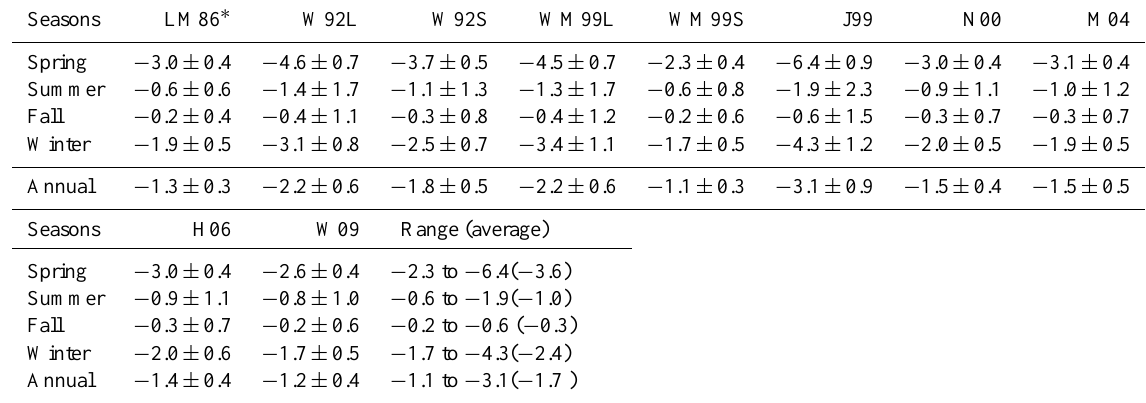
Table 4. Seasonal average CO 2 fluxes between 1998 and 2010 derived from the reported gas-transfer algorithms ∗ . Seasons LM86 ∗ W92L W92S WM99L WM99S J99 N00 M04 Spring − 3.0 ± 0.4 − 4.6 ± 0.7 − 3.7 ± 0.5 − 4.5 ± 0.7 − 2.3 ± 0.4 − 6.4 ± 0.9 − 3.0 ± 0.4 − 3.1 ± 0.4 Summer − 0.6 ± 0.6 − 1.4 ± 1.7 − 1.1 ± 1.3 − 1.3 ± 1.7 − 0.6 ± 0.8 − 1.9 ± 2.3 − 0.9 ± 1.1 − 1.0 ± 1.2 Fall − 0.2 ± 0.4 − 0.4 ± 1.1 − 0.3 ± 0.8 − 0.4 ± 1.2 − 0.2 ± 0.6 − 0.6 ± 1.5 − 0.3 ± 0.7 − 0.3 ± 0.7 Winter − 1.9 ± 0.5 − 3.1 ± 0.8 − 2.5 ± 0.7 − 3.4 ± 1.1 − 1.7 ± 0.5 − 4.3 ± 1.2 − 2.0 ± 0.5 − 1.9 ± 0.5 Annual − 1.3 ± 0.3 − 2.2 ± 0.6 − 1.8 ± 0.5 − 2.2 ± 0.6 − 1.1 ± 0.3 − 3.1 ± 0.9 Seasons H06 W09 Range (average) Spring Summer − 0.9 ± 1.1 − 0.3 ± 0.7 − 0.2 ± 0.6 − 0.2 to − 0.6 ( − 0.3) Winter − 2.0 ± 0.6 − 1.7 ± 0.5 Annual ∗ Abbreviations denote references with gas-transfer equations: LM86: Liss and Merlivat (1986), k 600 = 2 . 85 × u − 9 . 65 ( 3 . 6 < u < 13 . 0 ) W92L: Wanninkhof (1992, long-term), k 660 = 0 . 39 × u 2 W92S: Wanninkhof (1992, short-term), k 660 = 0 . 31 × u 2 WM99L: Wanninkhof and McGillis (1999, long-term), k 660 = 0 . 0283 × u 3 WM99S: Wanninkhof and McGillis (1999, short-term), k 660 = 1 . 09 × u − 0 . 333 × u 2 + 0 . 078 × u